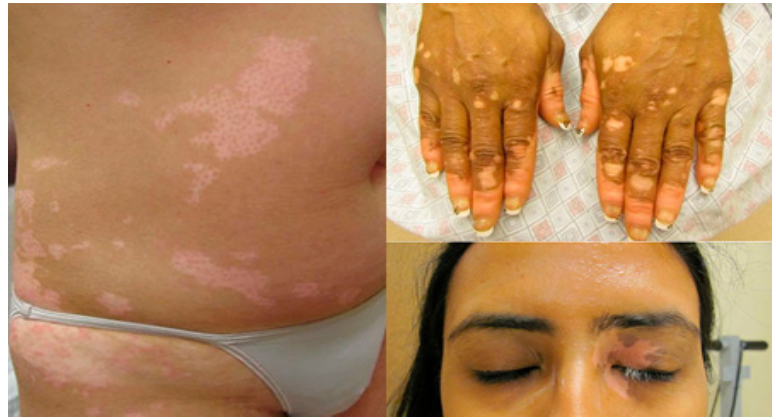
Figure 1. Vitiligo with typical lesions of the face and trunk [3].